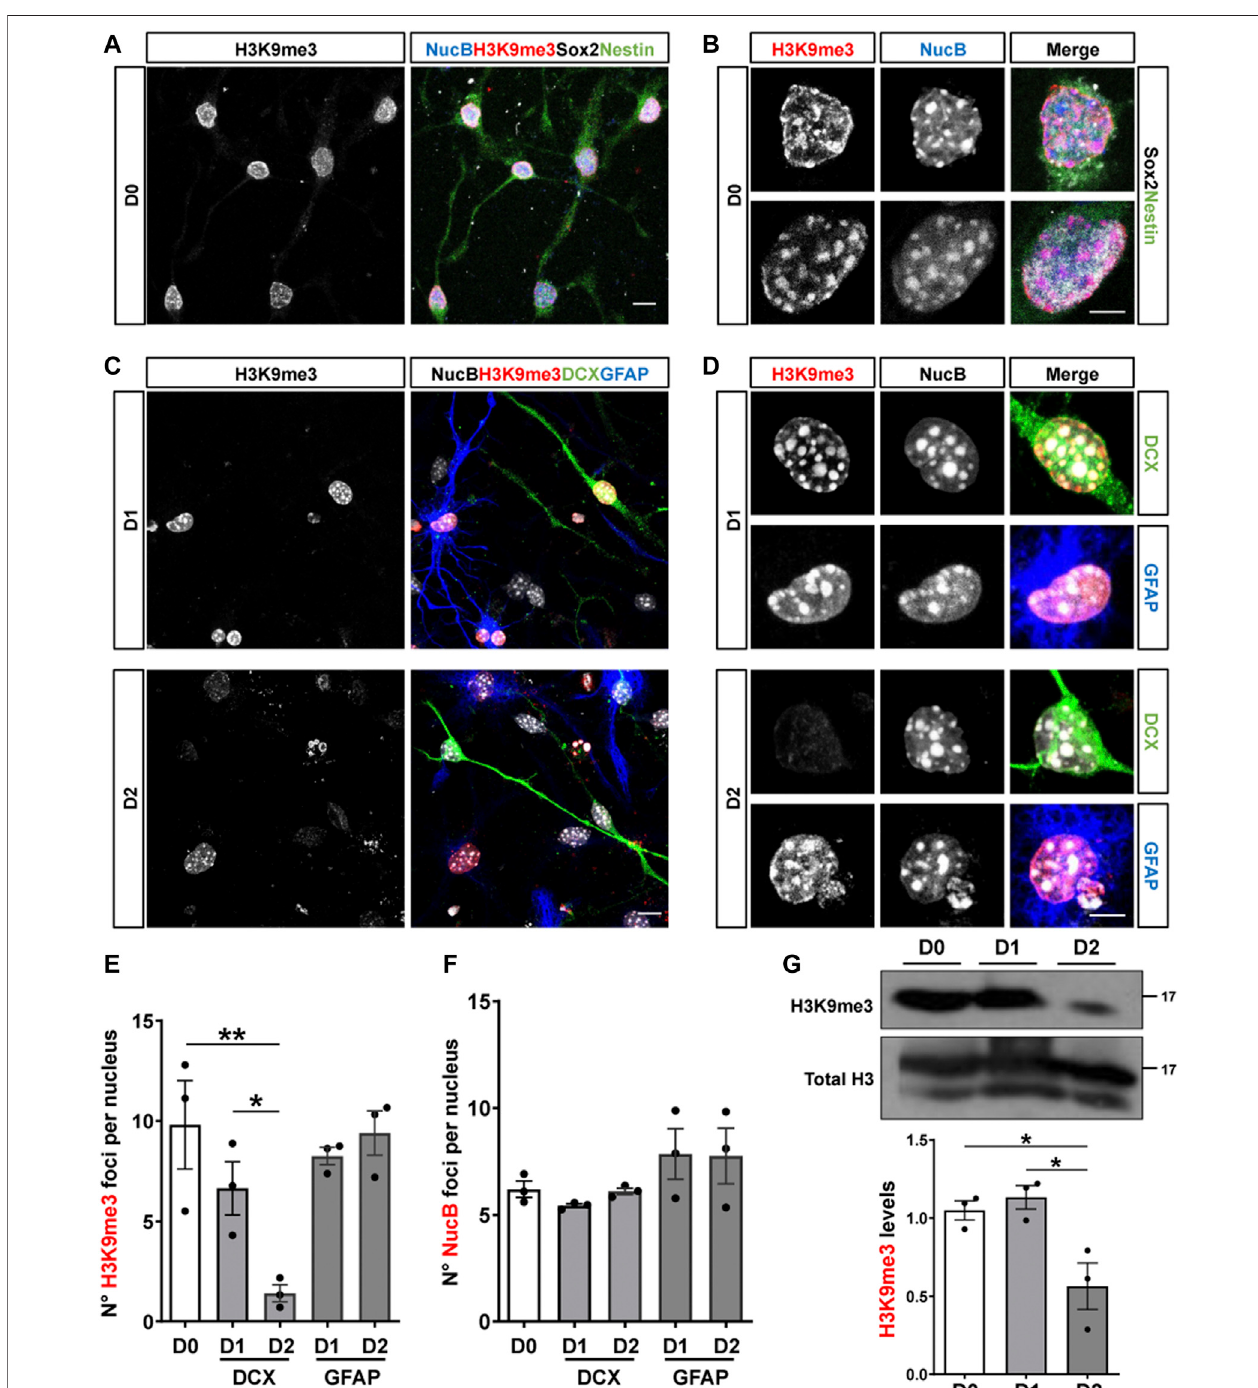
FIGURE 4 | Reduced expression of H3K9me3 upon differentiation of cultured adult hippocampal progenitors. (A,B) Immuno fl uorescence staining of H3K9me3 (red),Sox2(white),Nestin(green)andthenuclearstainingNucB(blue)inproliferative(undifferentiated,D0)AHP.Scalebar:10 μ m (A) ,5 μ m (B) . (C,D) Immunostainingof H3K9me3 (red), DCX (green), GFAP (blue) and NucB (white) in AHP differentiated by growth factor withdrawal for 24 (D1) and 48 (D2) h. Scale bar: 10 μ m (C) , 5 μ m (D) . (E,F) AveragenumberofH3K9me3 (E) andNucB (F) focipernucleusinAHPatD0,D1andD2. (G) ImmunoblotanalysisofH3K9me3innuclearextractsfromAHP atD0,D1andD2.H3K9me3proteinlevelswerenormalizedtototalH3.Numbersontherightindicatemolecularweight(kDa).Dataarepresentedasmean ± SEM; N (cid:1) 3 independent experiments. * p < 0.05, ** p < 0.01, one-way ANOVA followed by Bonferroni posthoc test.